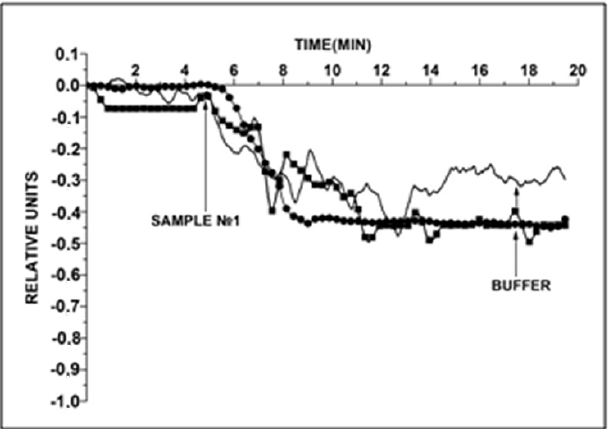
Figure 6. Typical sensogram curves obtained upon analysis of serum sample #1 (of hepatitis C patient) using p-type SOI-NW chip with covalently immobilized aptamers. Experimental conditions: 1 mM potassium phthalate bu ff er, pH 5.1, V g = ( − 45) V, V ds = ( − 0.2) V, V = 105 µ L. Each experiment was performed in three technical replicates ( n = 3: — 1st replicate, solid line, no marker; (cid:4) 2nd replicate, squares; • 3rd replicate, circles). Arrows indicate the addition of HCVcoreAg solution and wash with bu ff